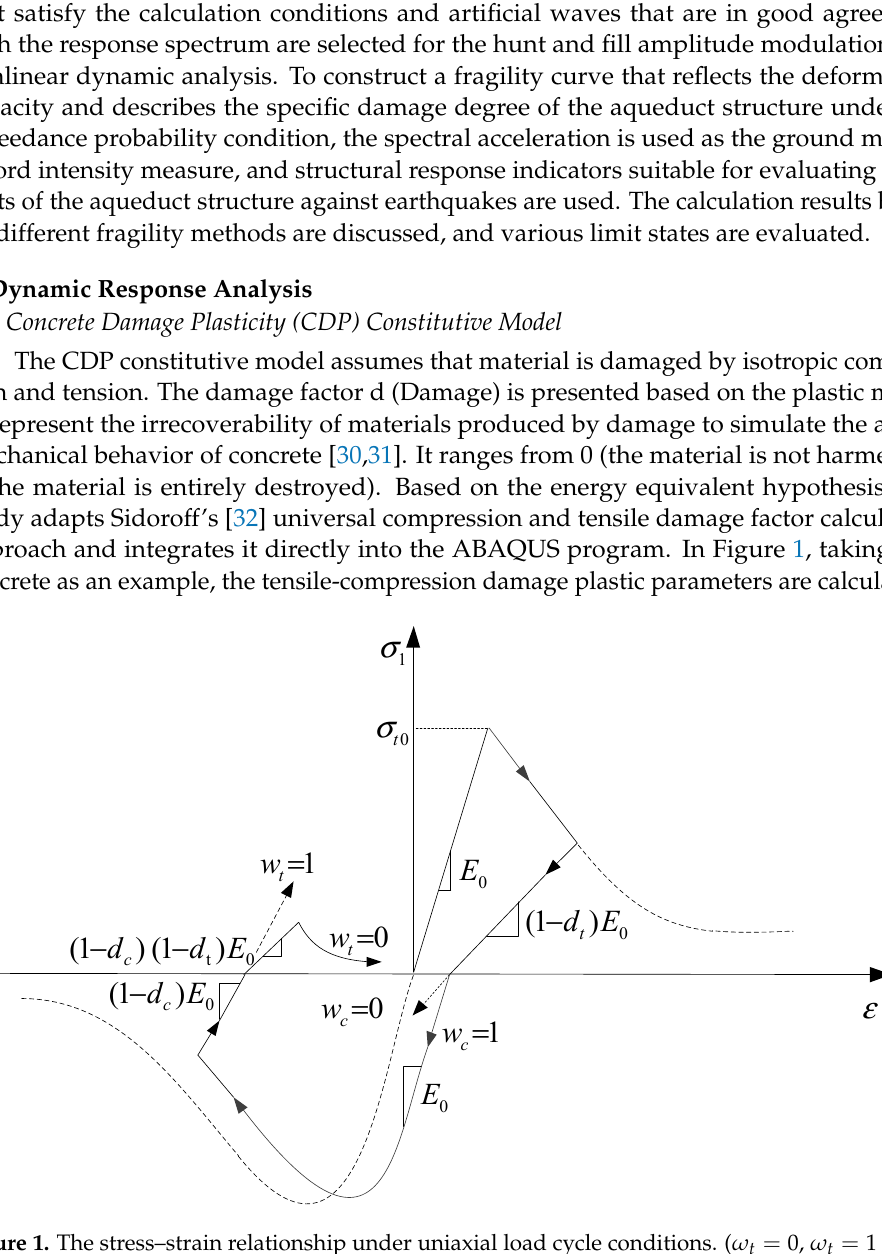
Figure 1. The stress–strain relationship under uniaxial load cycle conditions. ( 0 According to the plastic damage model theory in ABAQUS, the total strain tensor ε is composed of elastic strain rate ε el , and equivalent plastic strain rate ε pl can be determined as follows When there is no damage to the concrete, the stress-strain relationship of the concrete is in which σ is the total stress and D el is the elastic stiffness matrix. When the concrete is damaged, the material damage factor is introduced to describe the degradation of